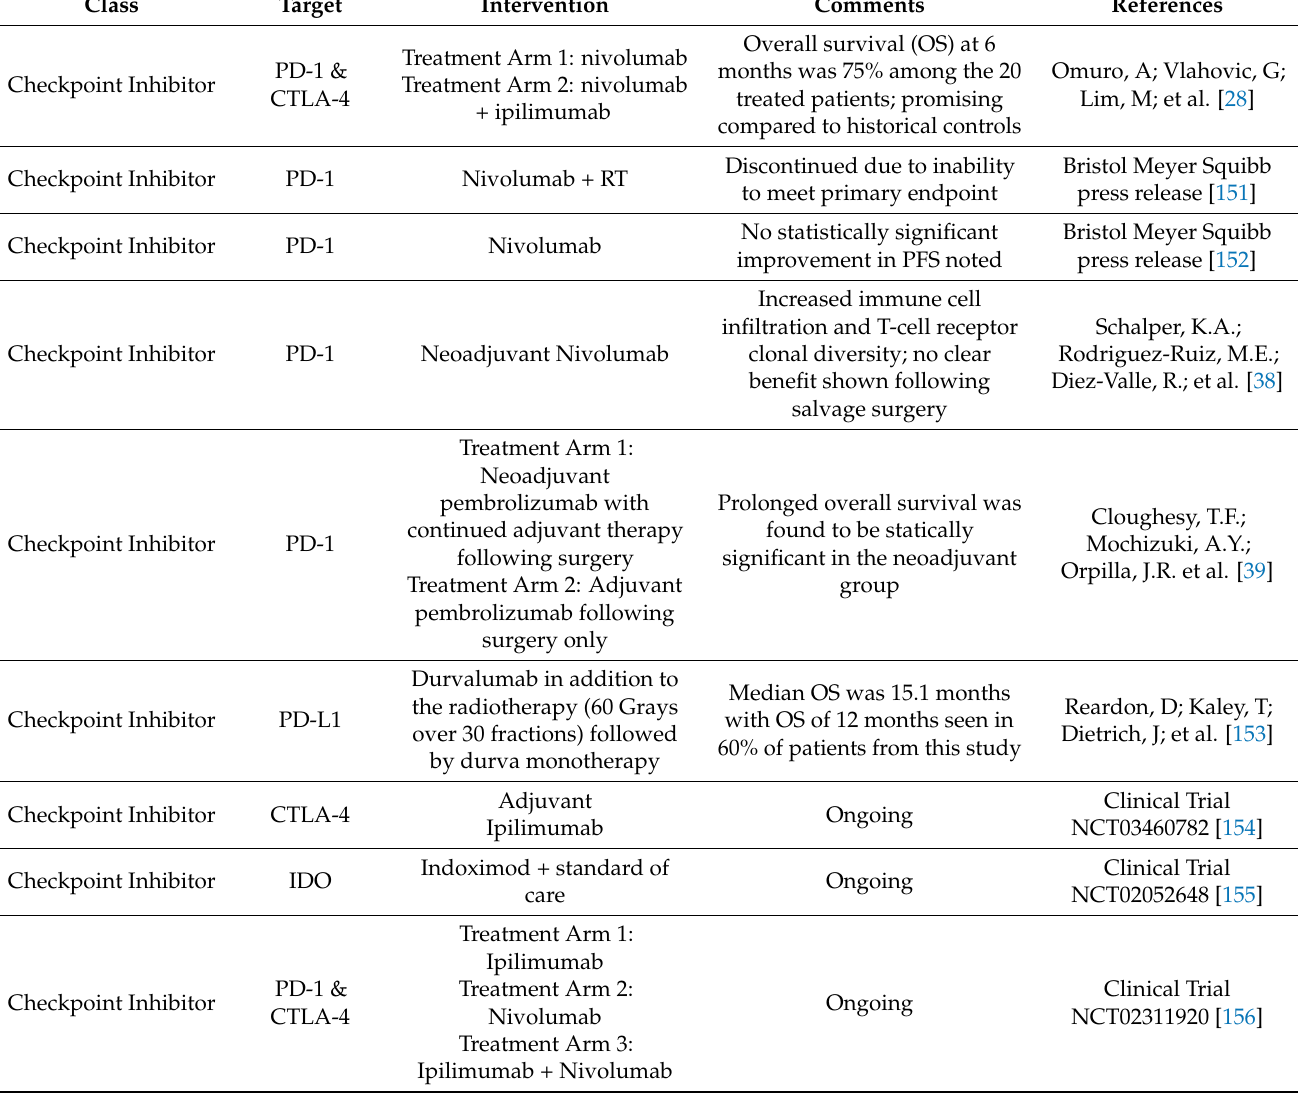
Table 1. Current immunotherapeutic strategies used in clinical